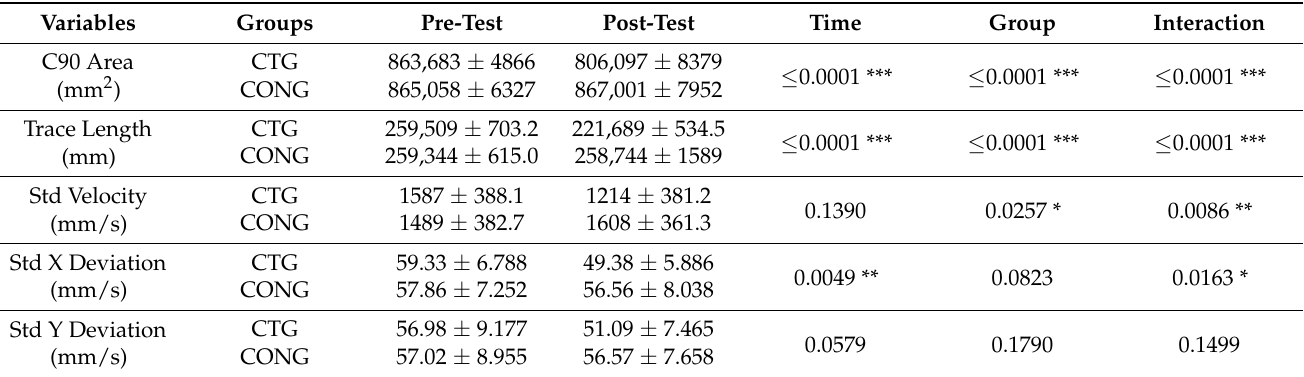
Table 9. Comparative analysis of various indicators of static balance before and after the experiment with eyes open and right foot standing (REO).